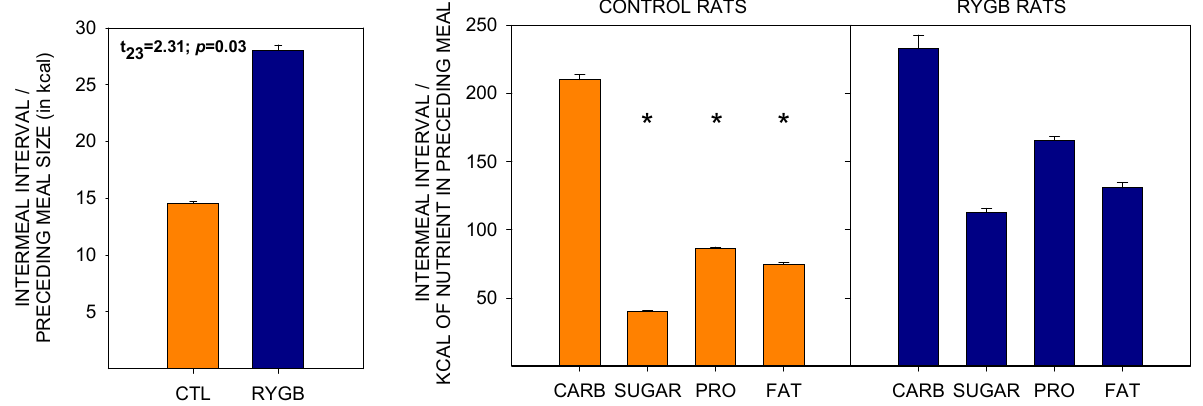
Figure 11. Satiety Ratios in a Meal and from Each Nutrient Type. Mean ( ± SE) satiety ratios for CTL (orange) and RYGB (blue) groups for meals from the last two days of post-surgical cafeteria diet access (days 15–16), calculated by dividing the intermeal interval (in min) by the total kilocalories in the previous meal (left), or by the kilocalories from a single nutrient type in the previous meal (right). The result of a two-sample t -test comparing satiety ratios of a full meal is inset in the left panel. Two-sample t -tests between groups were run to compare satiety ratios for each nutrient type. Carbohydrates: t 23 = 0.98; p = 0.09; Sugar: t 23 = 3.17, p < 0.01; Protein: t 23 = 3.91, p < 0.01; Fat: t 23 = 2.31; p = 0.03. *: significant results of two-sample t -tests comparing between groups.